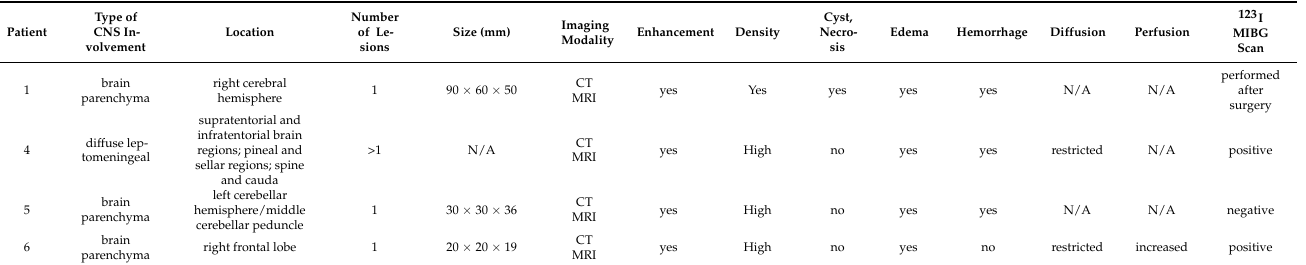
Table 2. Imaging features.